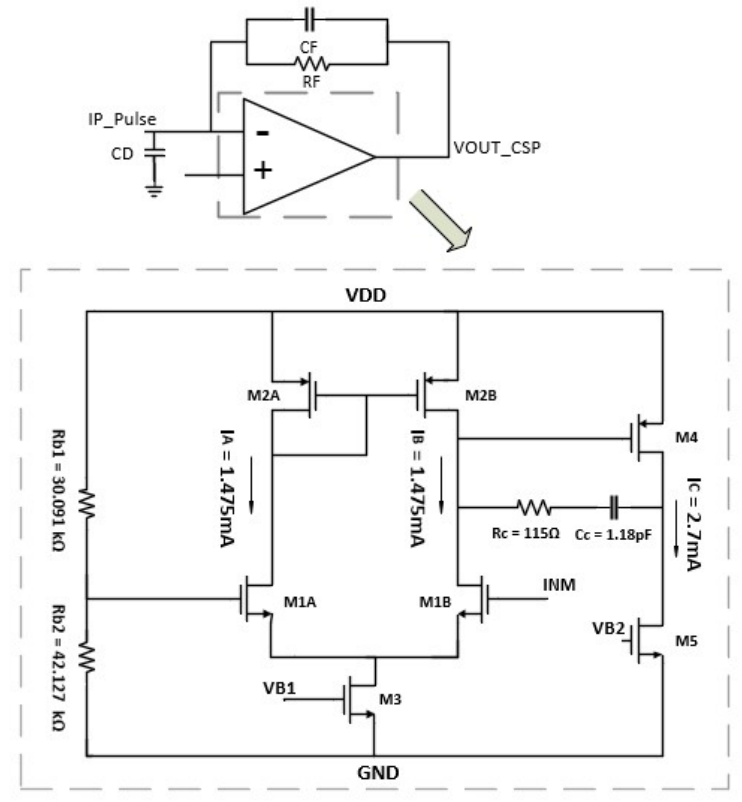
Figure 2. CSP and operational amplifier transistor-level